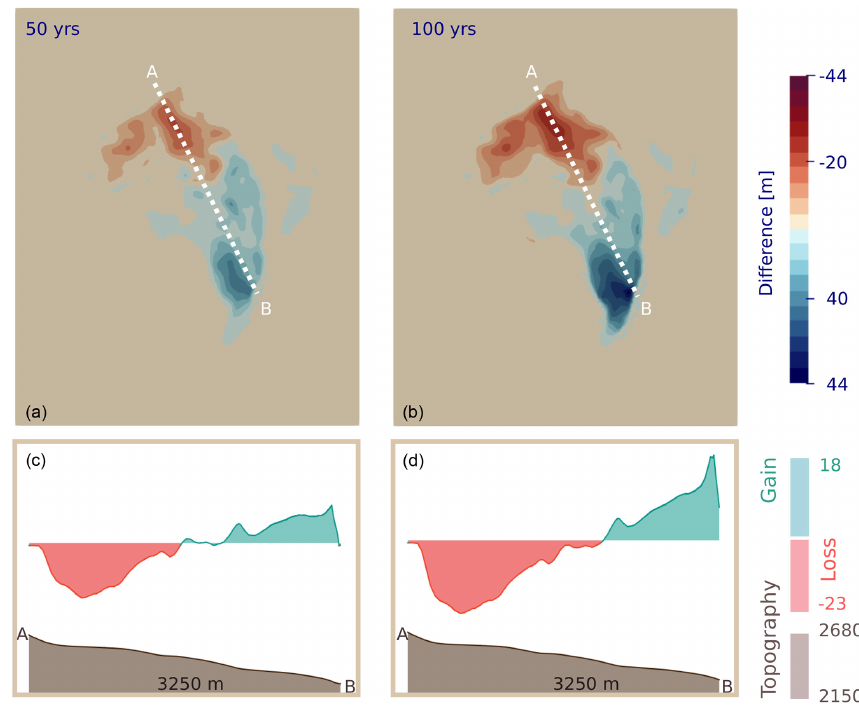
Figure 8. Zero mass balance test. View of the difference between initial surface elevation and simulation results at time steps (a) 50 and (b) 100 years and corresponding profiles with shaded surface topography in brown in (c) and (d) .